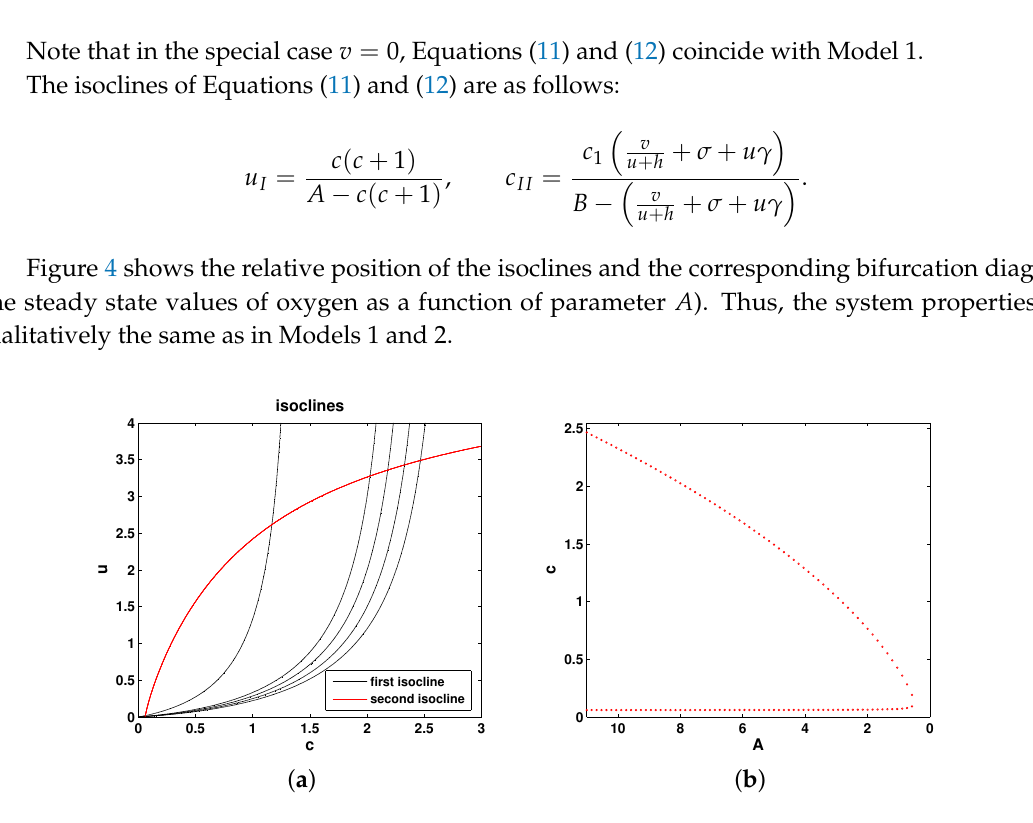
Figure 4. ( a ) The (null-)isoclines of the oxygen-phytoplankton system for Model 3. Black curves show the oxygen isocline ( u I ) for A = 3.5,8,9,10 and 11 (from left to right, respectively), and the red curve shows the phytoplankton isocline ( c II ). ( b ) Positive steady states of Equations (11) and (12) shown as functions of A . Here, v = 0.3 and h = 0.5, and other parameters are the same as in Figure